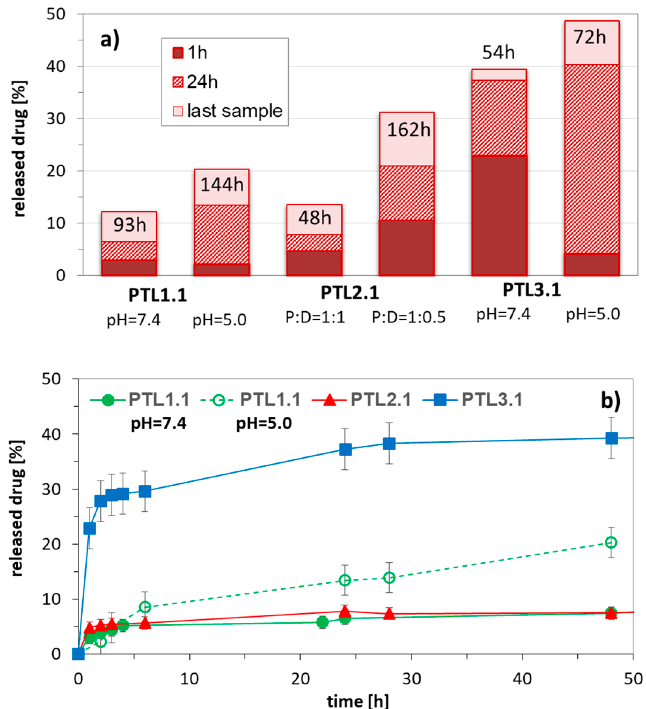
Figure 4. Influence of pH and weight ratio of polymer to encapsulated drug on amount of released drug in correlation with composition of 4-armed copolymers of MMA / MAA (PTL1.1), MMA / AA (PTL2.1), and MA / MAA (PTL3.1) with equimolar content of hydrophilic fraction ( a ), and representative release profiles of IMC ( b ) in PBS at 37 ◦